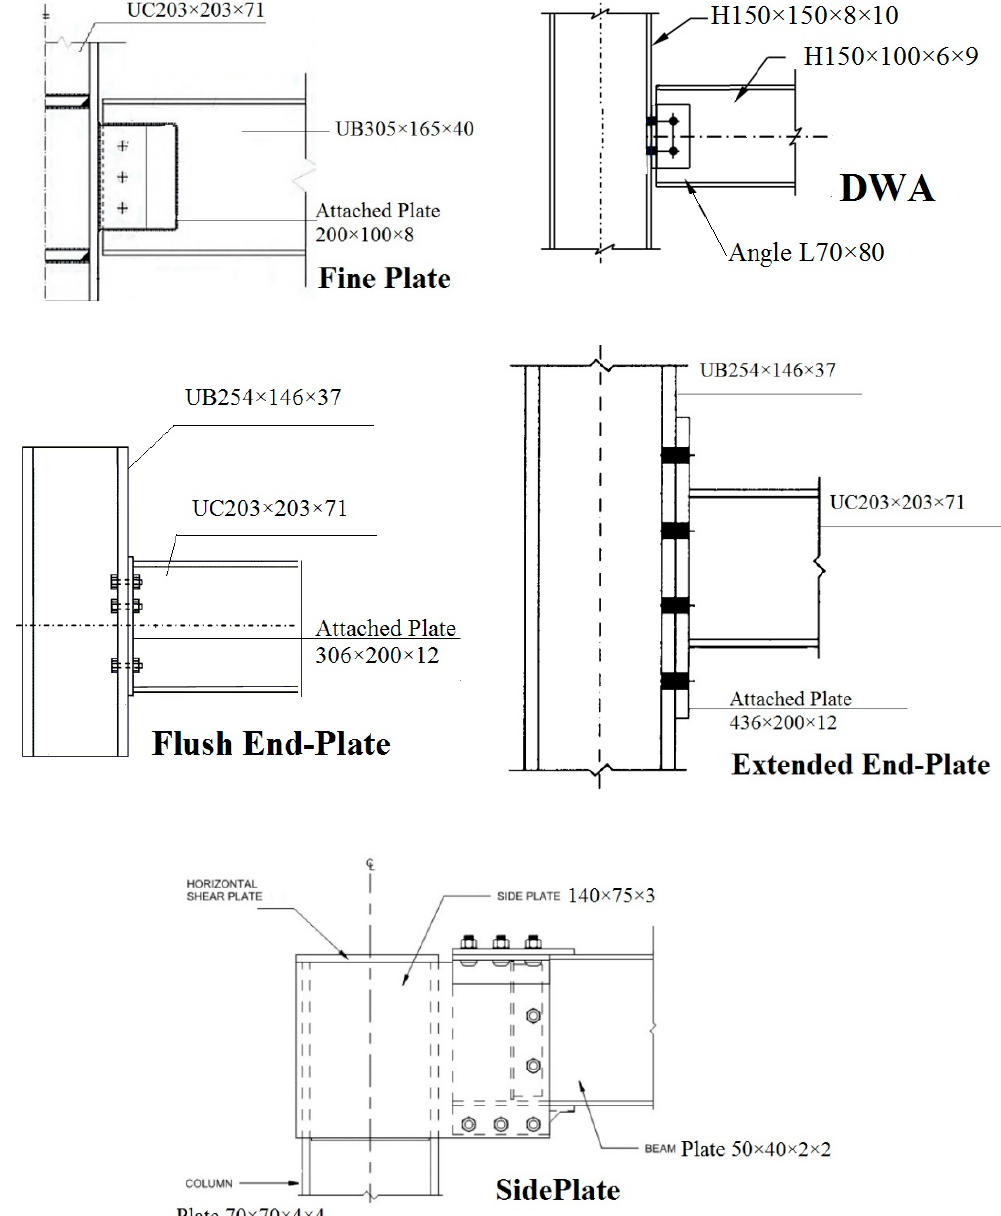
Figure 3. Configuration and geometric details of studied connections.